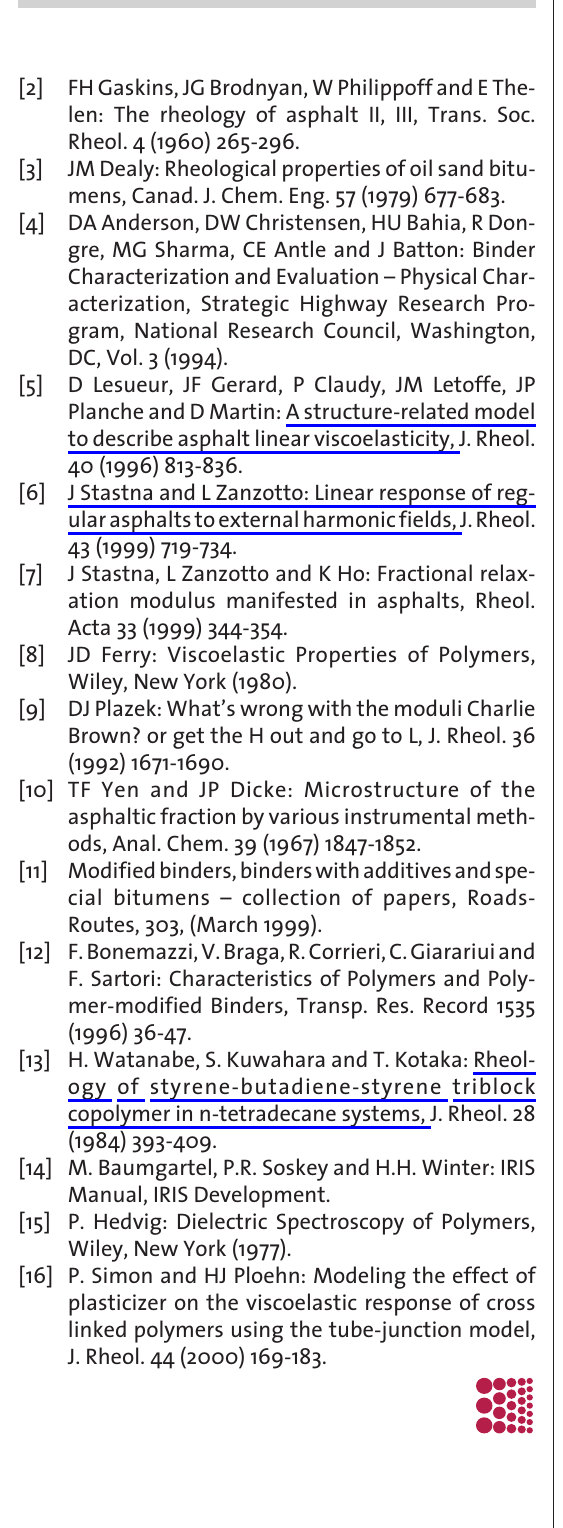
Figure 12 (left): Isochrones, 10 rad/s; relative loss modulus ( • Base, •+• 6% SBSr, (cid:3)(cid:3) 4% EVA, ◊ 2% SBSr, + 2% EGA). Figure 13: Modified loss tangent (T r = 0°C: (cid:3)(cid:3) Base, ◊ 8% SBSr, − experimental, • fractional model, Eq.